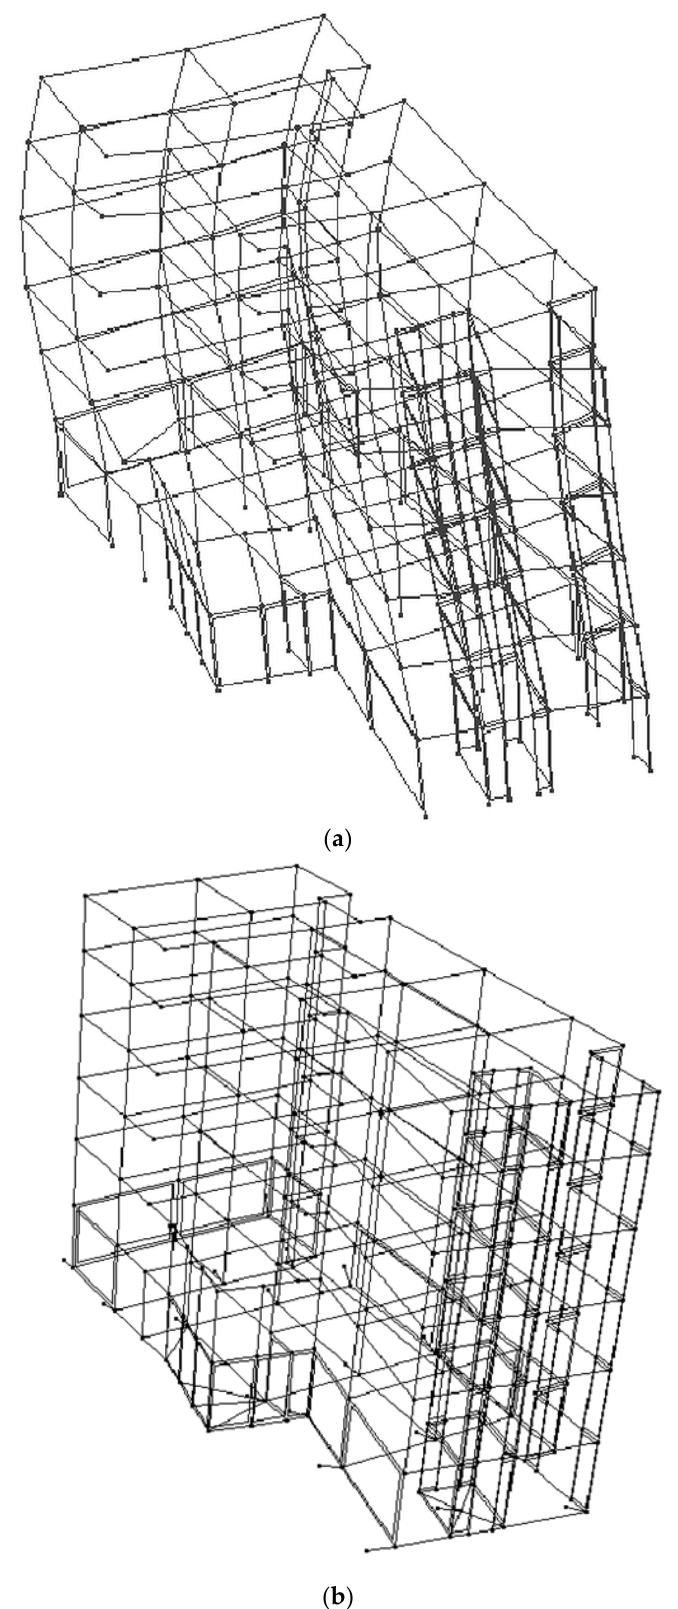
Figure 12. Deformed shapes at maximum ground acceleration: ( a ) classic building; ( b ) base-isolated structure.